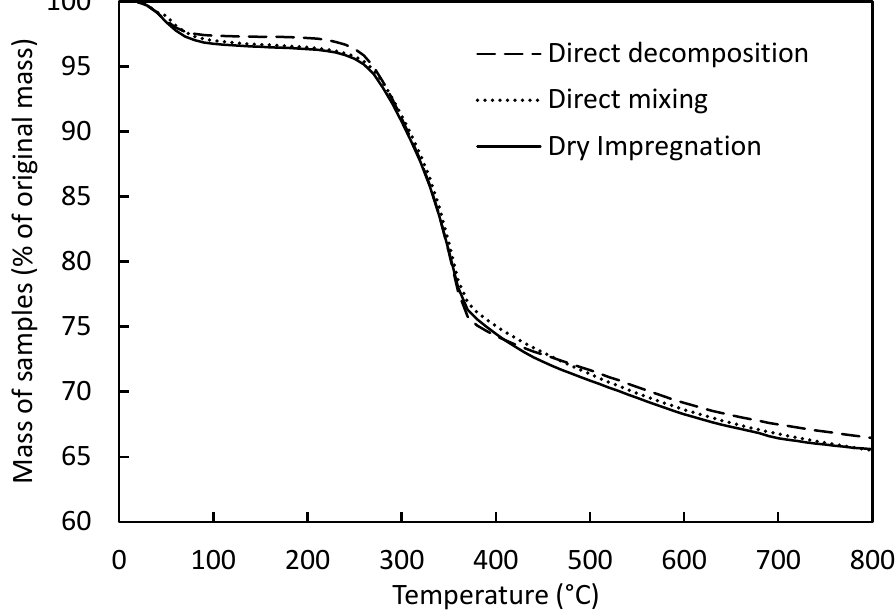
Figure 5. Thermogravimetric (TGA) profiles for the oxidation of biomass using the Fe-Cu oxide with 60% Fe 2 O 3 / 10% CuO / 30% Al 2 O 3 prepared by various methods at a 0.4:1 mass ratio of biomass to